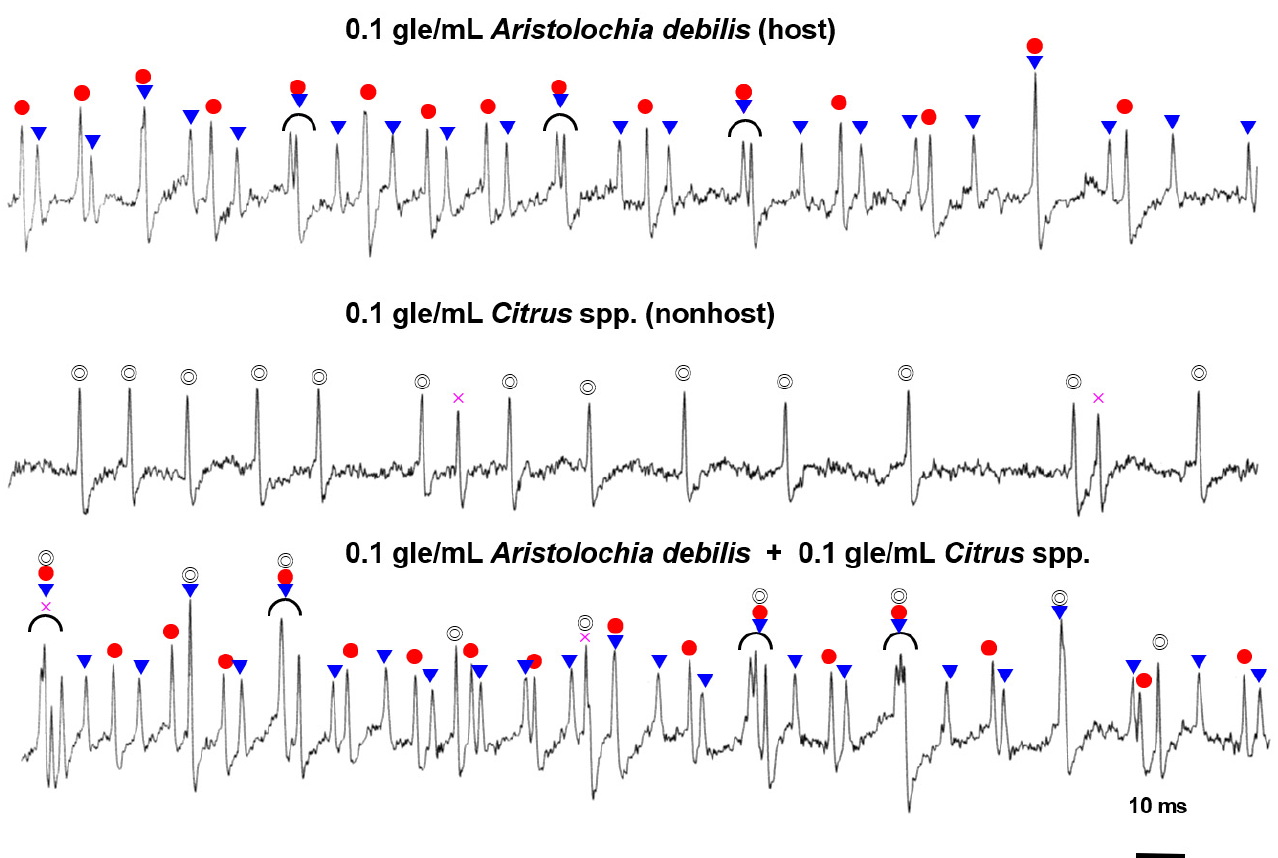
Figure 5. Electrophysiological responses to extracts of host and nonhost plants and their mixture from female long-type sensilla a with no recorded sensitivity to sucrose (La). Responses from three different classes of cells could be discriminated. ● : class 1; ▼ : class 2; ◎ : class 3; ×: unidentified. “gle/mL” indicates gram leaf equivalent in 1 mL of control solution.